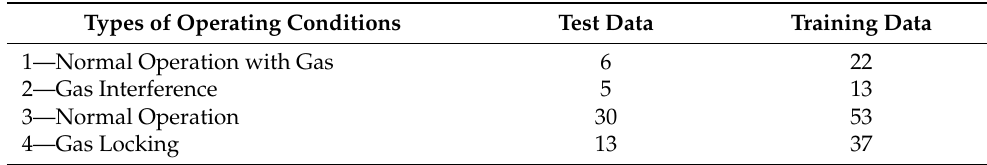
Table 2. Distribution of testing and training